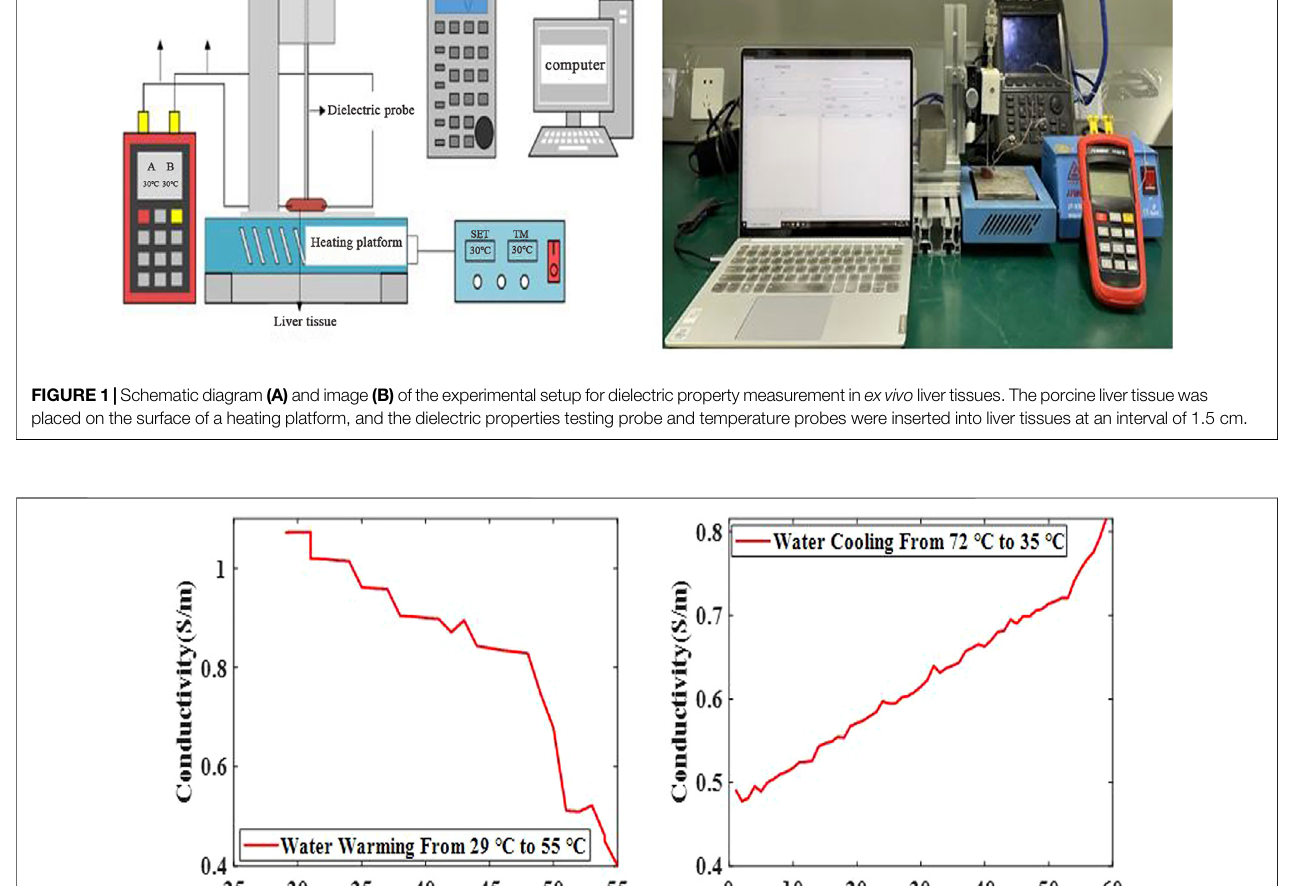
Frontiers in Physics |